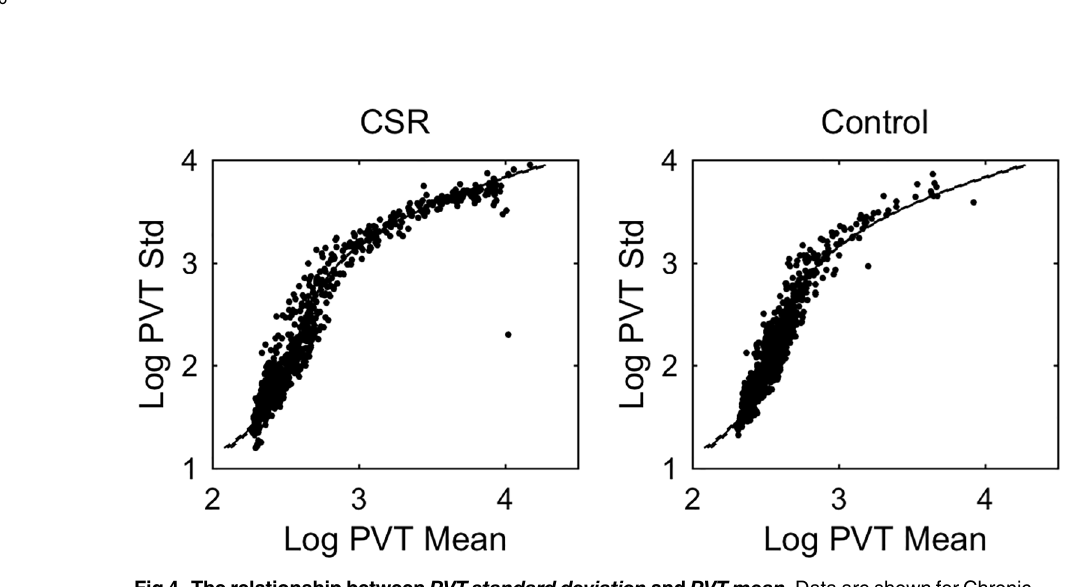
Fig 3. Subjective Alertness scores by Circadian Phase and Wake Duration . Mean Subjective Alertness scores are plotted as a function of Circadian Phase (zero degrees is the fit melatonin maximum) and Wake Duration (hours elapsed in scheduled wake episode). The top panel contains data from the Chronic Sleep Restriction (CSR) condition. The bottom panel contains data from the Control condition. Each column shows one week (four 42.85-h “ days ” ) of data.